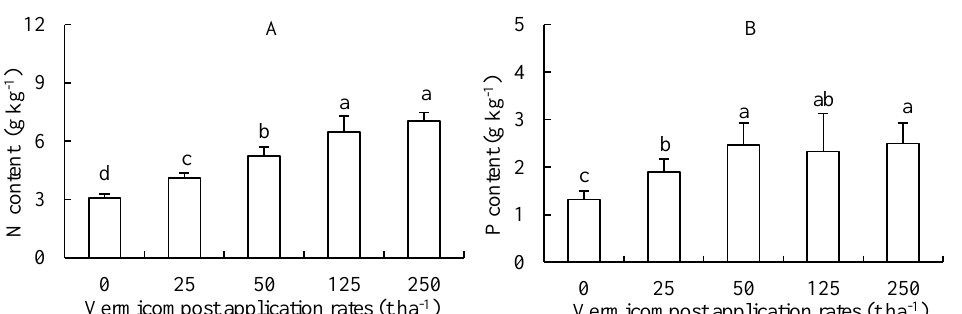
Figure 2. Effects of vermicompost application on N ( A ) and P ( B ) content of barley grown in mudflat salt-affected soil. Values are the mean of three replicates, and bars show standard deviation. Columns with different letters show a significant difference between sewage sludge amendment rates at p < 0.05 by LSD’s multiple range test. N, nitrogen; P, phosphorus.